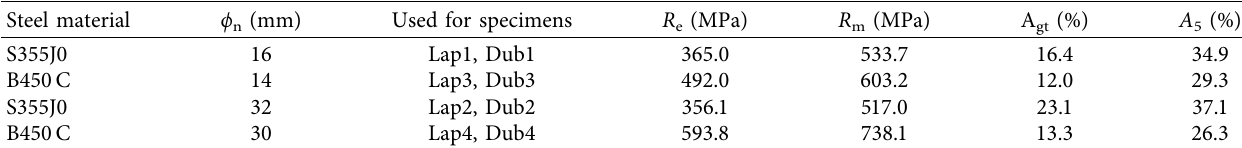
Table 2: Results of tensile tests on the